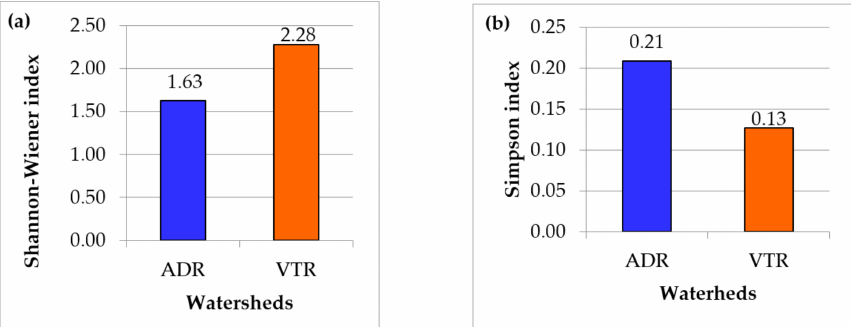
Figure 8. The Shannon–Wiener ( a ) and Simpson ( b ) diversity index for all three riparian sampling stations where insects were collected for Arkoudorema (ADR) (blue column) and Vathirema (VTR) (orange column).